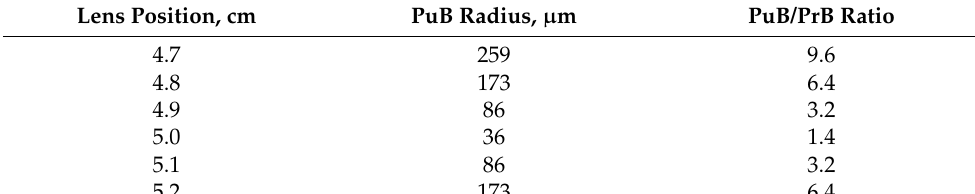
Table 1. Values of PuB radii for different position of forming lens and ratio of PuB/PrB radii.